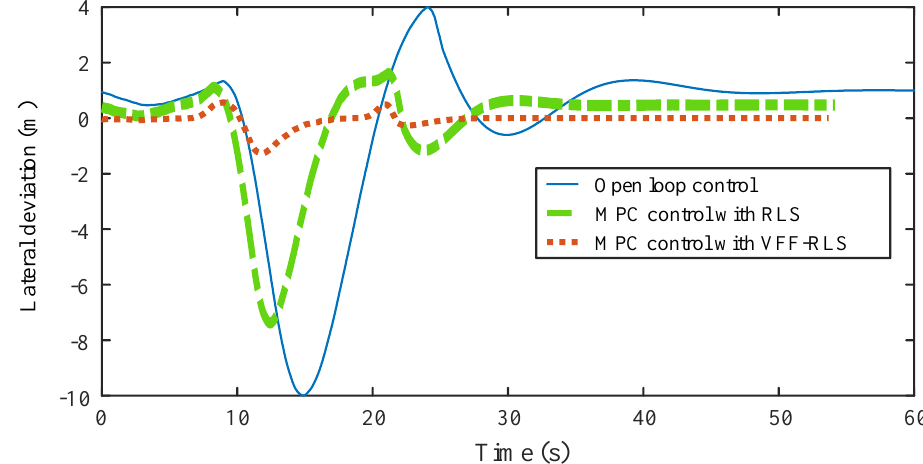
Figure 16. Lateral deviation under Scenario B.